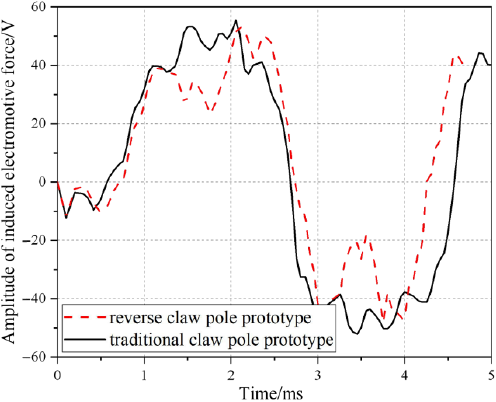
Figure 19. Curve change diagram of induced electromotive force under 100 Ω load.